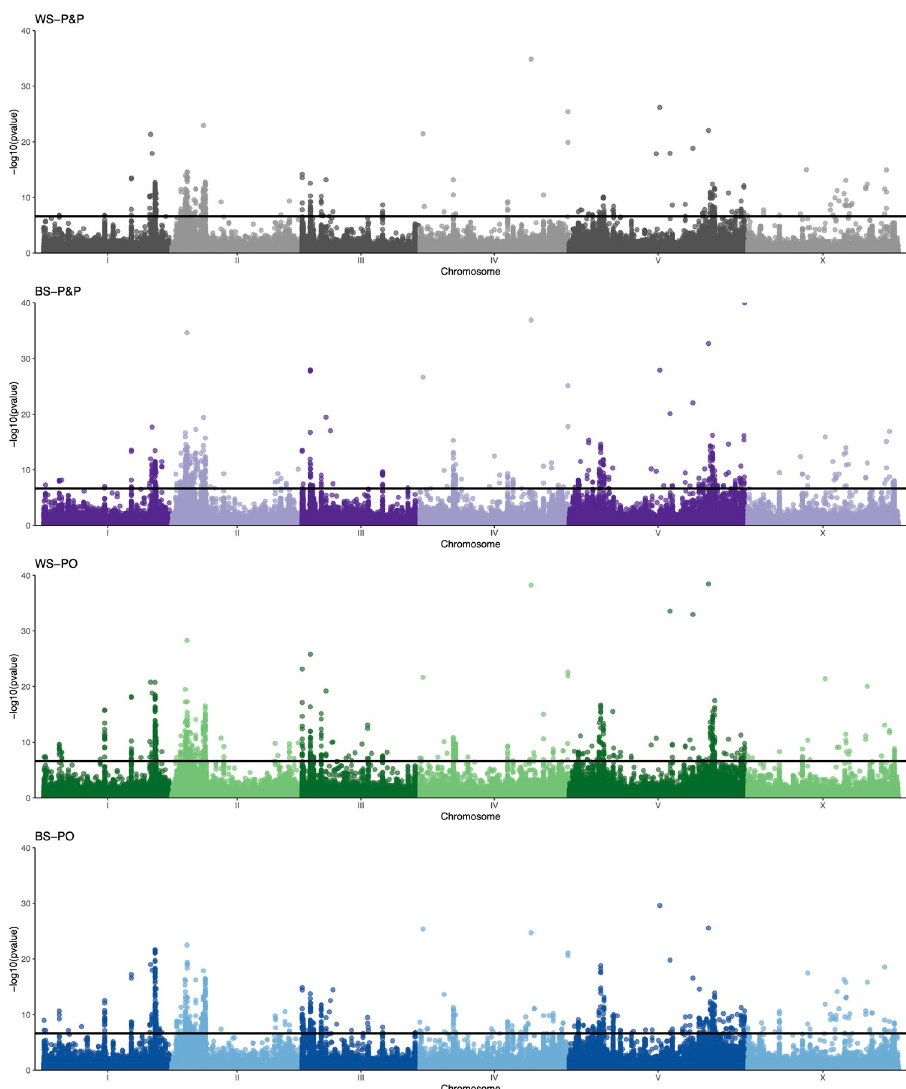
Fig 3. Genomic response for each SNP over time fit for each regime (Model 2). The horizontal line represents the Bonferroni significance threshold. Reproductive success is a highly polygenic trait with 40 peaks identified in the WS-P&P regime (gray), 71 in the BS-P&P regime (purple), 71 in the WS-PO regime (green), and 82 in the BS-PO regime (blue). The distribution of peak overlaps in shown in Fig